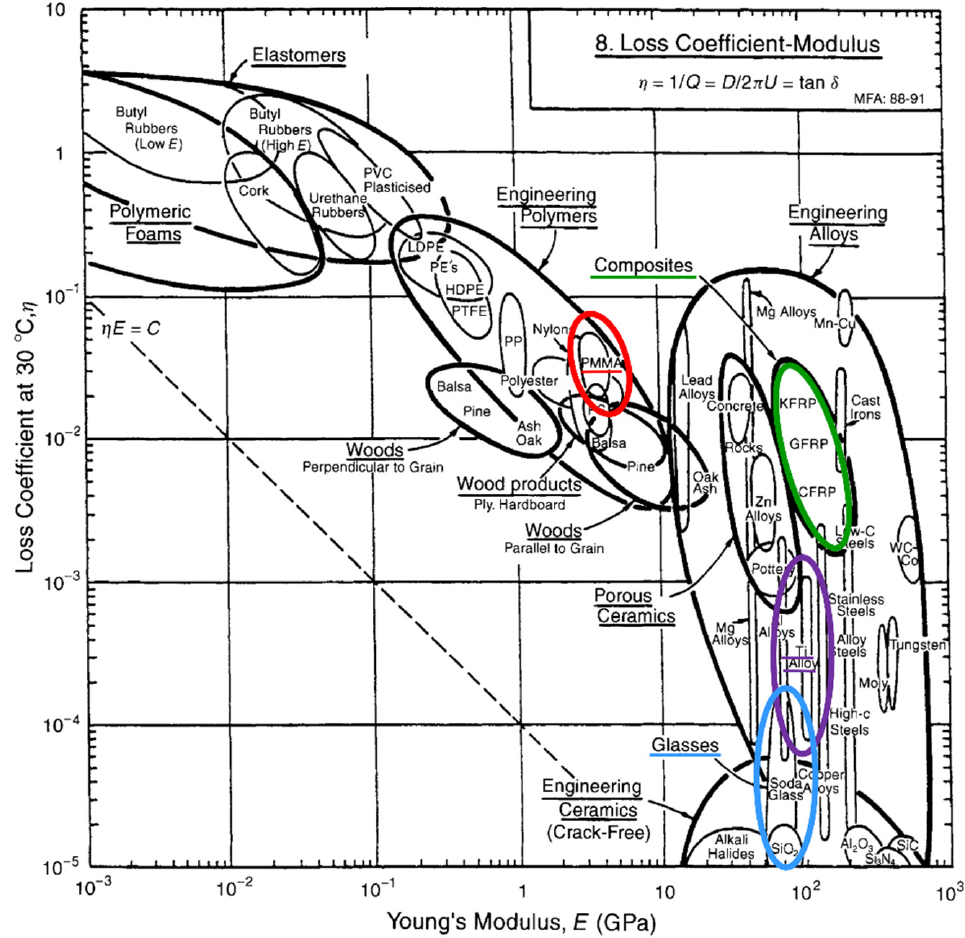
Figure 1. Relationship between Young’s modulus and loss tangent (loss coefficient). Original Ashby diagram [15] (This diagram was published in Materials Selection in Mechanical Design, Michael F. Ashby, page 432. Copyright 1999 by Elsevier) Colored cycles represent different material types (red, polymer-based; green, composite; violet, metal and alloys; blue, glass and ceramic).